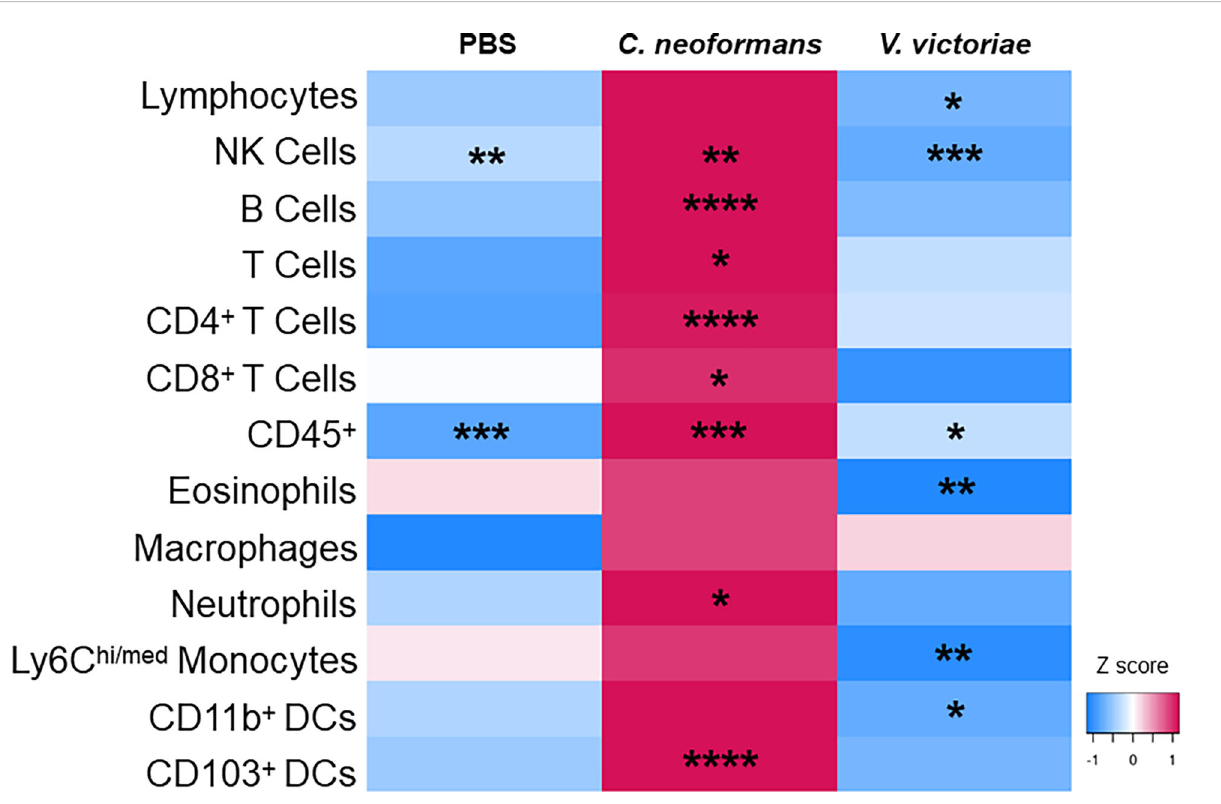
FIGURE 6 Repeated C. neoformans exposure continues to increase cell populations in the BALF at 21 days post fi nal exposure. Mean cell quanti fi cations in BALF following repeated exposure to PBS, 10 4 C. neoformans cells or 10 6 V. victoriae cells at 1 day post fi nal exposure compared to 21 days post fi nal exposure. n=3-7 per group. Values used for this heatmap were obtained by calculating the average quantities at 21 days post fi nal exposure and subtracting the average quantities at 1 day post fi nal exposure. A positive Z score (pink) indicates that the quanti fi cation of cells increased at 21 days post fi nal exposure compared to 1 day post fi nal exposure. Negative Z scores (blue) indicate that the cell quanti fi cations decreased by 21 days post fi nal exposure compared to 1 day post fi nal exposure. Asterisks overlaying the heatmap indicate P values comparing the quanti fi cations of each time point for the same exposure. *P<0.05, **P < 0.01, ***P < 0.001, ****P < 0.0001. P values were determined by ordinary one-way ANOVA with Sidak ’ s multiple comparisons test comparing the same exposure at 1 day post fi nal exposure and 21 days post fi nal